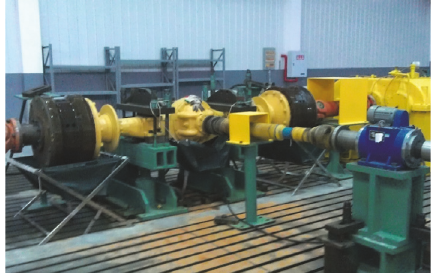
Figure 5: Bench testing setup.